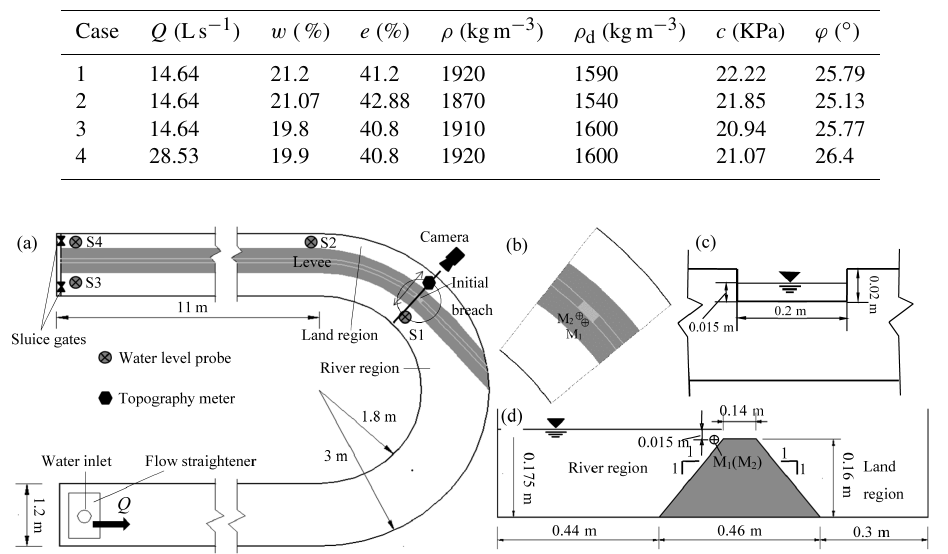
Table 1. Experiment cases and parameters.